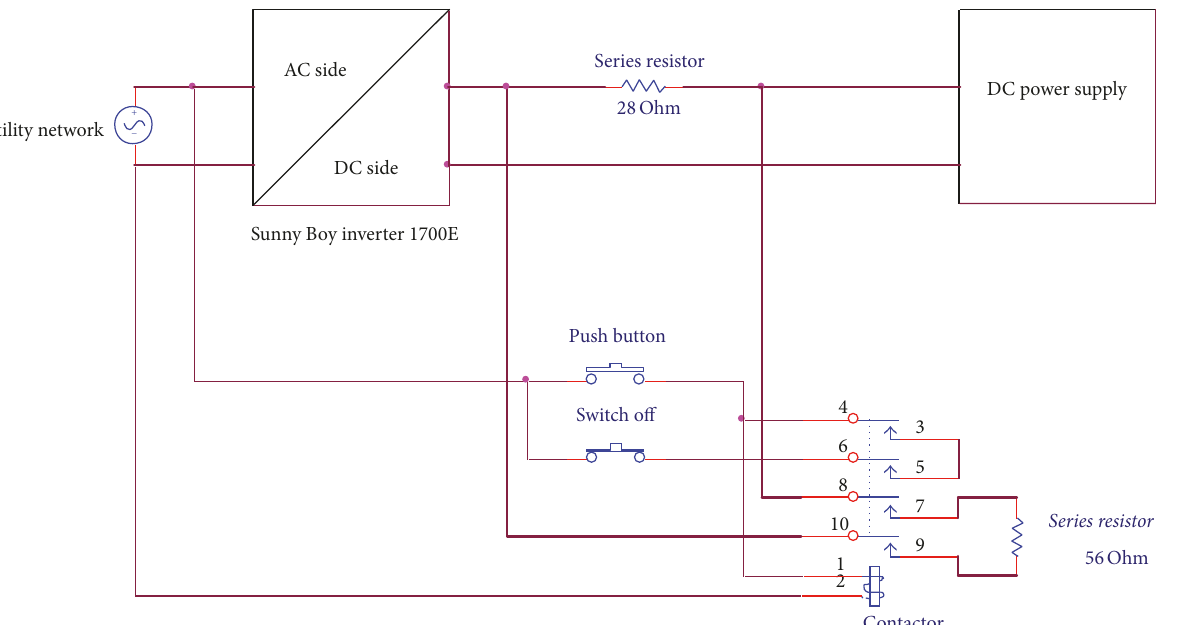
Figure 9: Circuit diagram for testing the MPPT and the speedy response of the SB 1700E inverter.